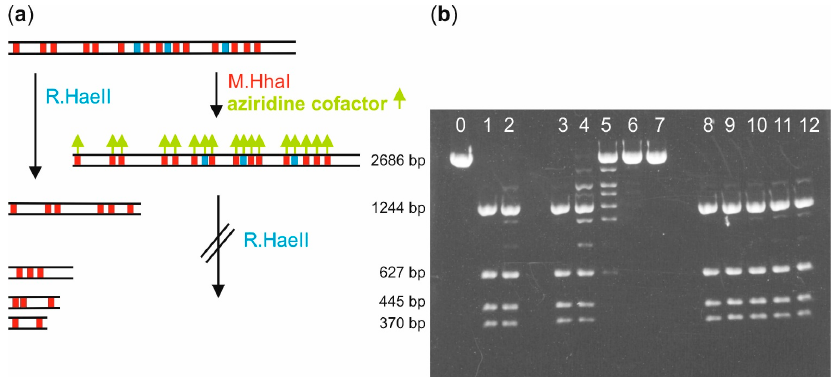
Figure 3. Biotin labeling of plasmid DNA with aziridine cofactor 5 and M.HhaI. ( a ) Schematic representation of the modification-protection assay used to demonstrate labeling of linearized pUC19 plasmid DNA (LpUC19). Coupling of an aziridine cofactor (green arrows) with the M.HhaI recognition sequences 5 ′ -G C GC-3 ′ (red/blue boxes) by M.HhaI leads to protection of a subset of sites (blue boxes)